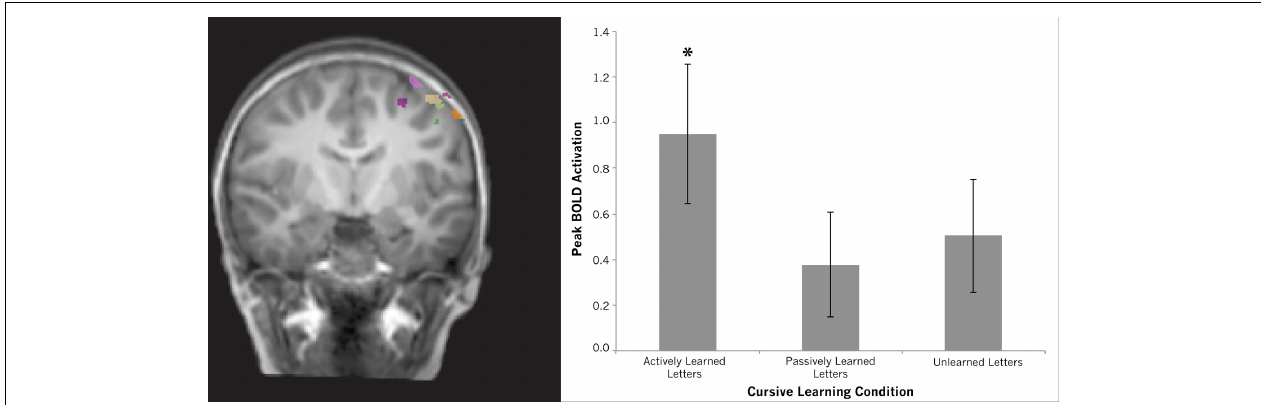
FIGURE 8 | Region of interest results for the left motor cortex. Brain map shows individual regions-of-interest superimposed on a typical brain. Graph shows differences among conditions extracted from these regions. Although